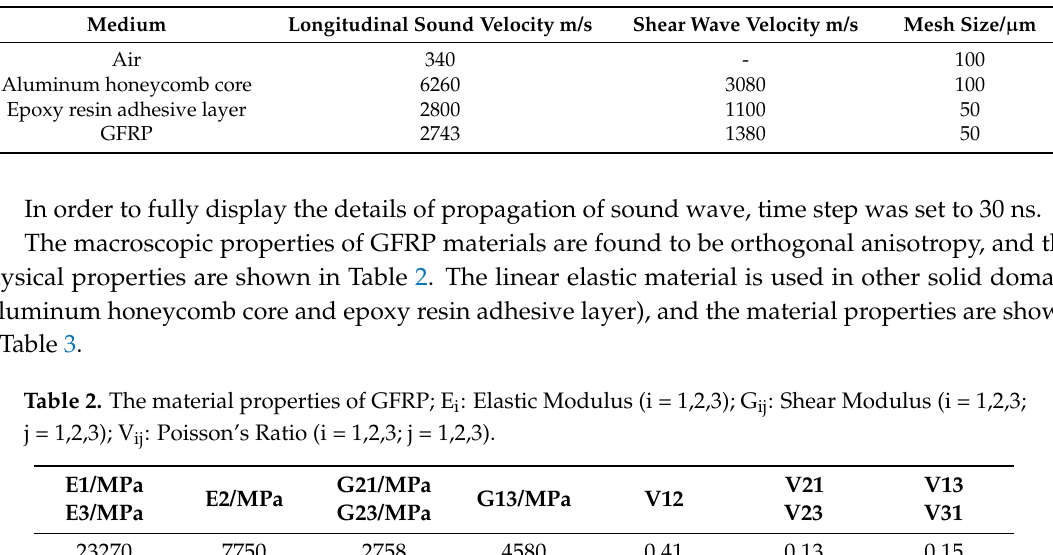
Table 1. The actual size information of each component of honeycomb sandwich composite; GFRP: glass fiber reinforce polymers.